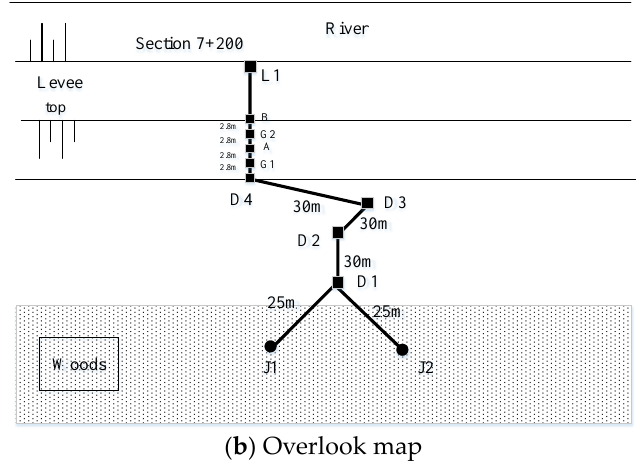
Figure 8. Measuring points layout for HTL.